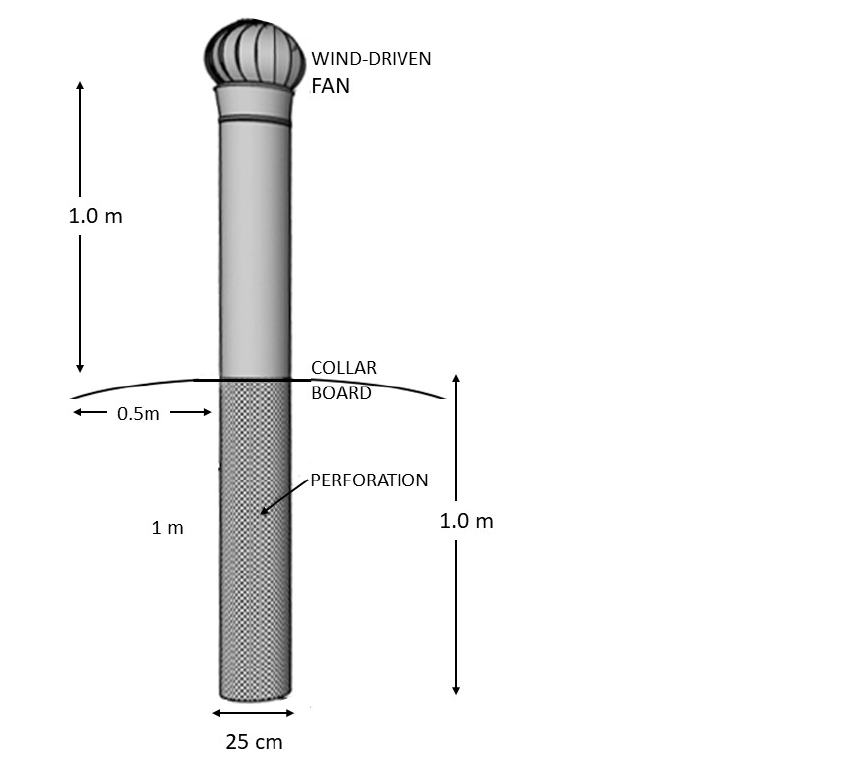
Figure 2. Illustration of the metallic (galvanized 1 mm steel) ventilation pipes installed on two un- covered piles (2 per pile). The lower halves of the pipe walls were perforated, and wind-driven fans were placed on the top of the pipes. The perforated parts of the pipes were buried in the piles, and their lower ends were approximately 2.5 m above the ground.